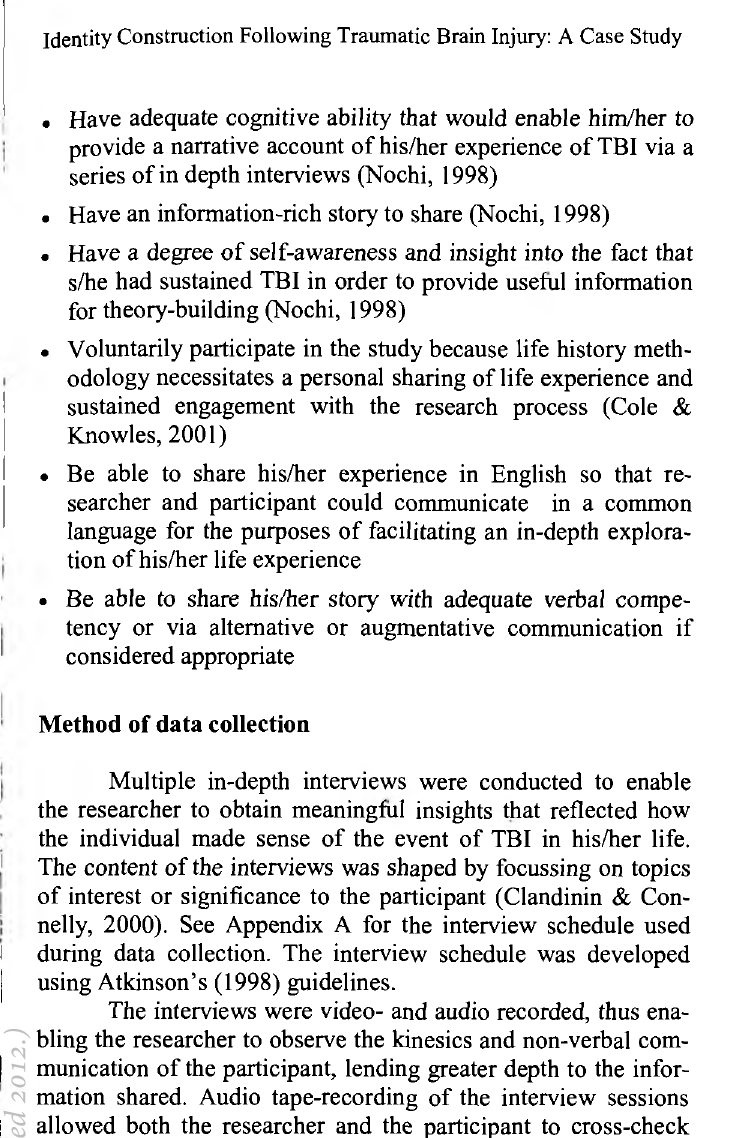
Table 1: Outline of research